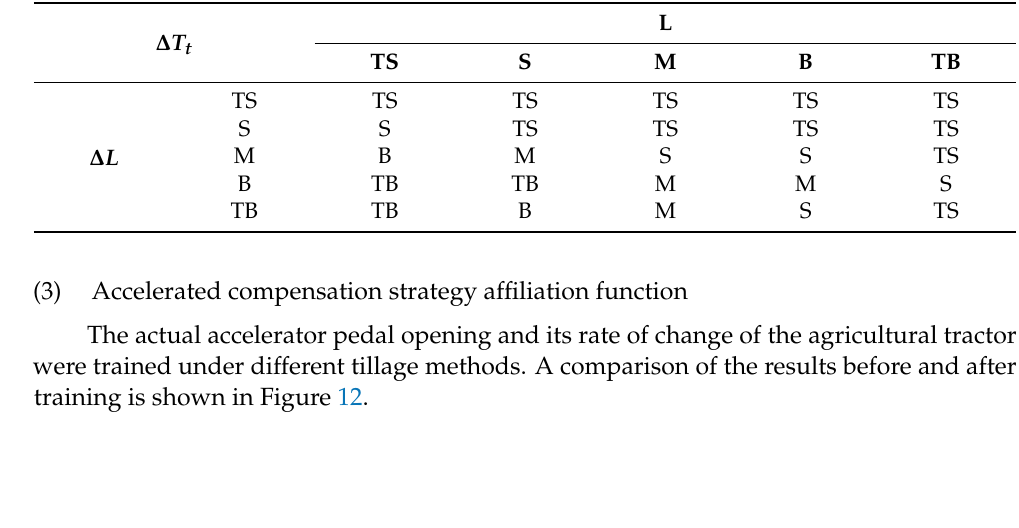
Table 4. Fuzzy control